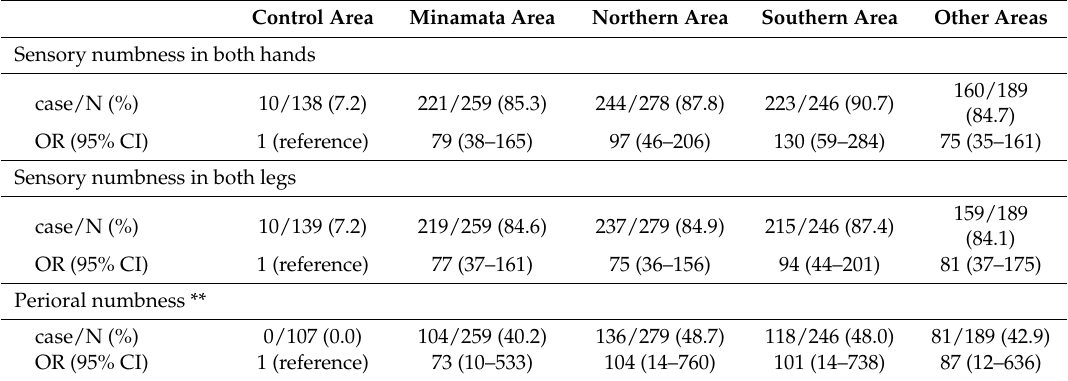
Table 5. Prevalence of symptoms (Always and Sometimes) and adjusted * odds ratios (OR) for the association between area and symptoms ( n =